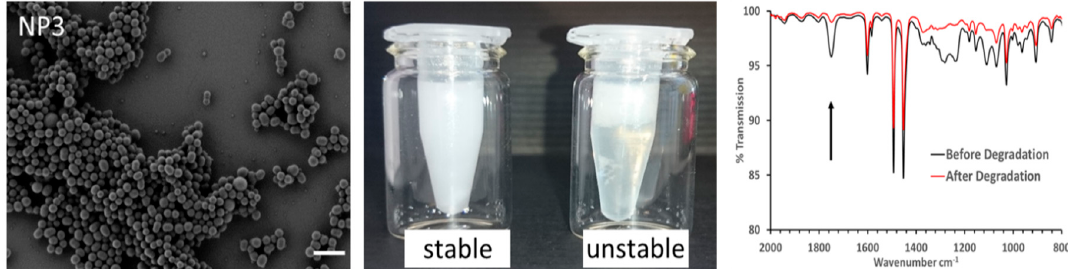
8 of 12 Figure 5. In situ 1 H-NMR degradation study of mPEG 113 - b -PPC 49 (Table 1, sample 3) in conc. DCl. Comparison of the degradation products propylene carbonate (red), propane-1,2-diol (blue) and both together (black) in units per mPEG 113 . A scanning electron microscopy (SEM) image of sample NP3 is shown in Figure 6, and the images of NP2, NP4 and NP6 are shown in the Supplementary Information (Figure S12). Furthermore, the nanoparticle diameter and PDI were determined by DLS (Table 2). The results show that each of the tested polycarbonate surfactants can be used to prepare stable polystyrene nanoparticles. Surfactants with HLB values above 10 stabilized PS nanoparticles efficiently with narrow size distribution (NP2, NP3 and NP4 in Table 2). The successful stabilization is independent of the length of the hydrophilic block (NP2 and NP4) and of the wt % of PPC (NP2 and NP3). Remarkably, the results of sample 3 (NP3) are comparable to established surfactants (Lutensol AT50) for this polymerization technique. However, if the hydrophobic block becomes too dominant and the HLB value decreases below 10, the surfactant produced PS dispersions with polydisperse size